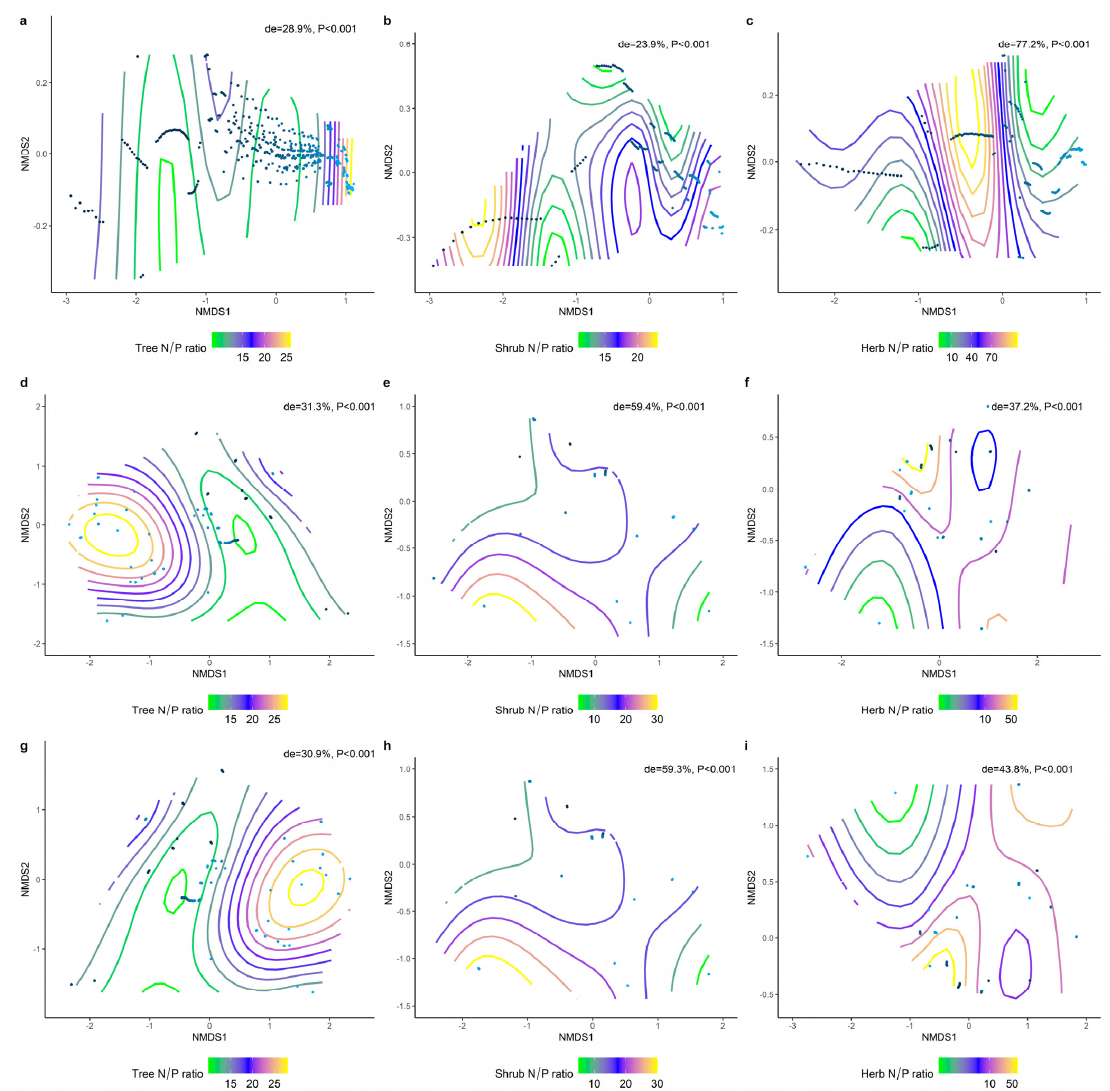
Figure 11. The NMDS ranking of climatic and soil factors with different life forms of N/P. Value of de represents the deviation explained by the corresponding model. ( a ) NMDS ranking of soil factors with tree levels N/P; ( b ) NMDS ranking of soil factors with shrub levels N/P; ( c ) NMDS ranking of soil factors with herb levels N/P; ( d ) NMDS ranking of climatic factors with tree levels N/P; ( e ) NMDS ranking of climatic factors with shrub levels N/P; ( f ) NMDS ranking of climate factors and herb levels N/P; ( g ) NMDS ranking of the sum of soil factors and climate factors and tree levels N/P; ( h ) NMDS ranking of the sum of soil factors and climate factors and shrub levels N/P; ( i ) NMDS ranking of the sum of soil factors and climate factors and herb levels N/P. Trait stacking indicates that abiotic factors, indicated by points on the NMD, are associated with higher or lower trait values, consistent with a colored trait gradient. Note that if the relationship between N/P and abiotic factors is linear, the gradient splines will be parallel. Nonlinear relationships between N/P and abiotic fac- tors are represented by curve splines.